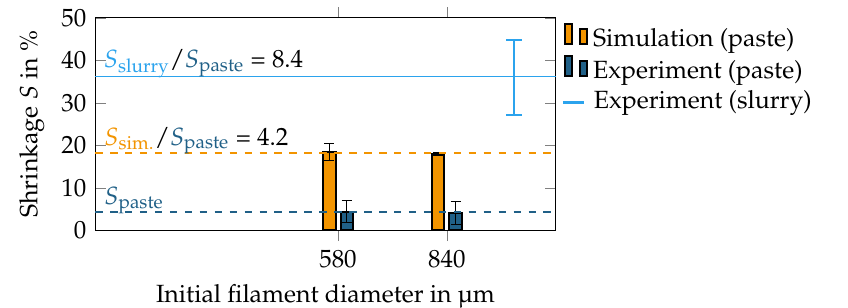
Figure 8. Filament shrinkage during drying as observed in the experiment and measured in the sim- ulation. The error bars denote one standard deviation. The horizontal lines represents the mean shrinkage for a certain category.